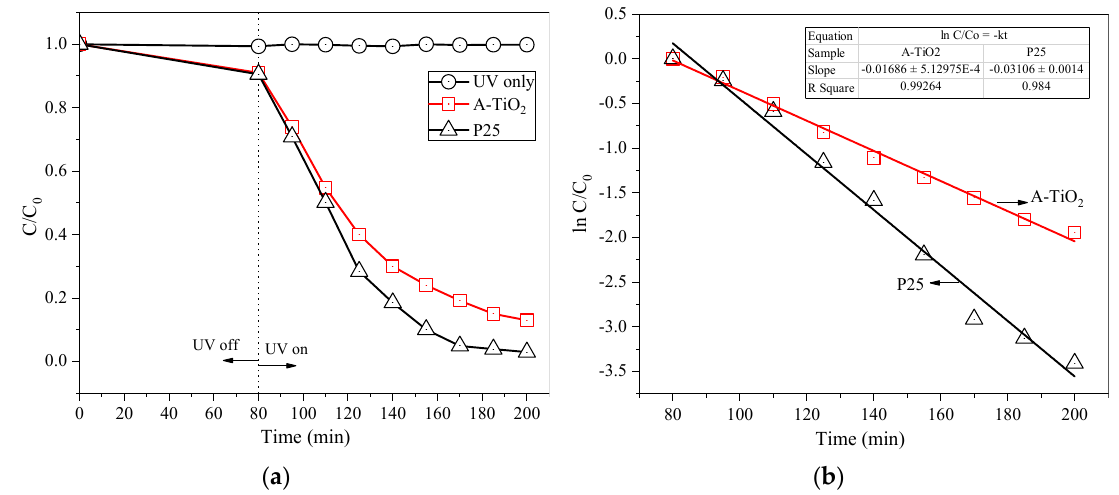
Figure 5. ( a ) Removal rate of acetaldehyde and, ( b ) first-order kinetics under UV irradiation over A-TiO 2 and P25 NPs.